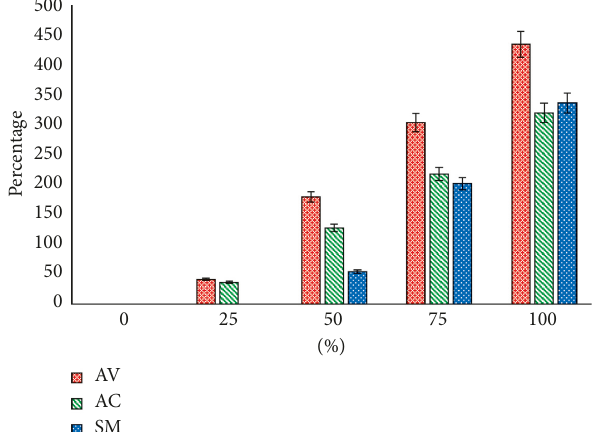
Figure 1: The PIDG indicates the percentage inhibition of MRSA against some concentration of AV, AC, and SM